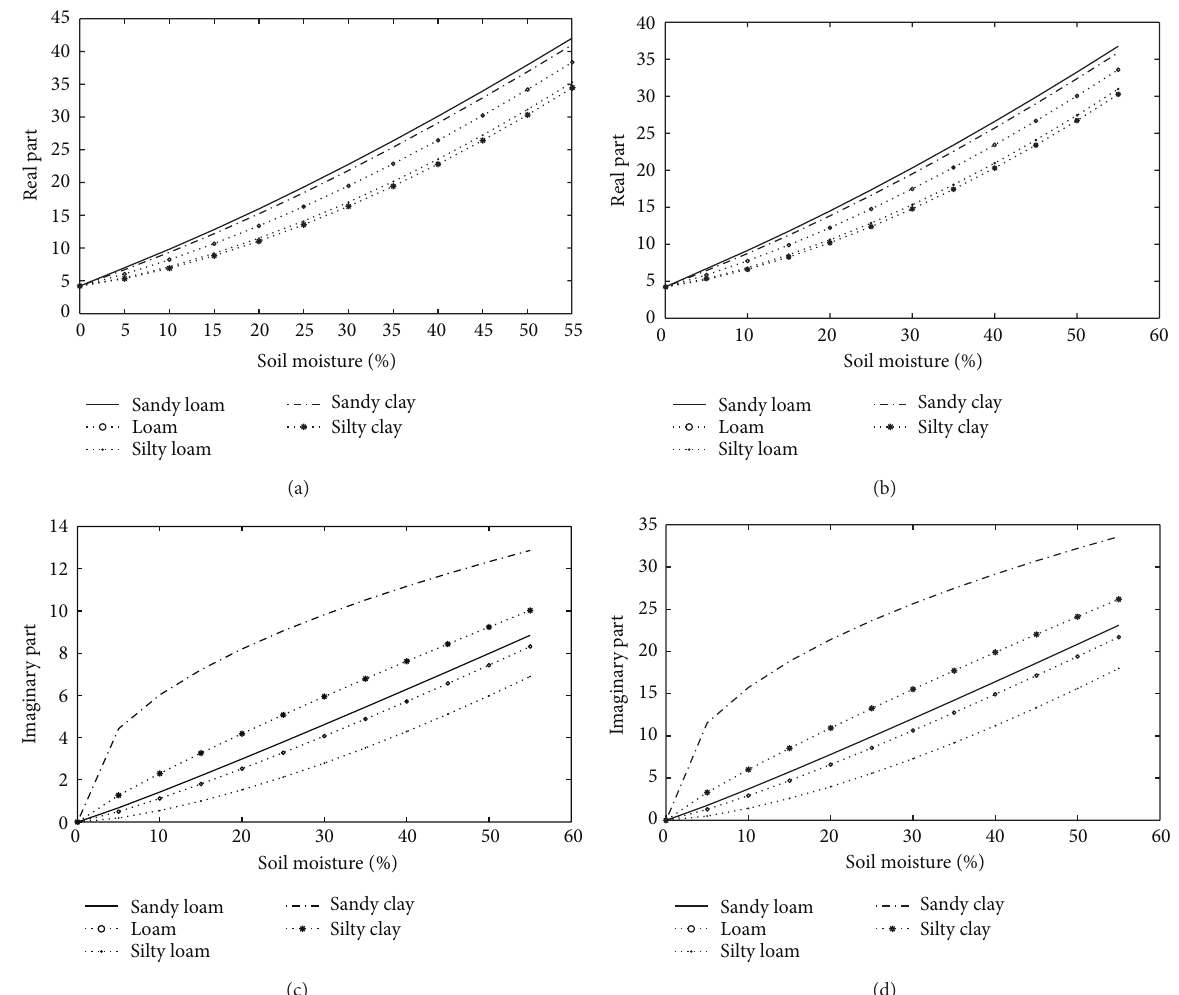
Figure 4: Effect of soil texture on the dielectric constant in nonsalt-affected soil (on the left) [12] and 60‰ in salt-affected soil (on the right). (a) Texture effect on real part (0‰), (b) texture effect on real part (60‰), (c) texture effect on imaginary part (0‰), and (d) texture effect on imaginary part